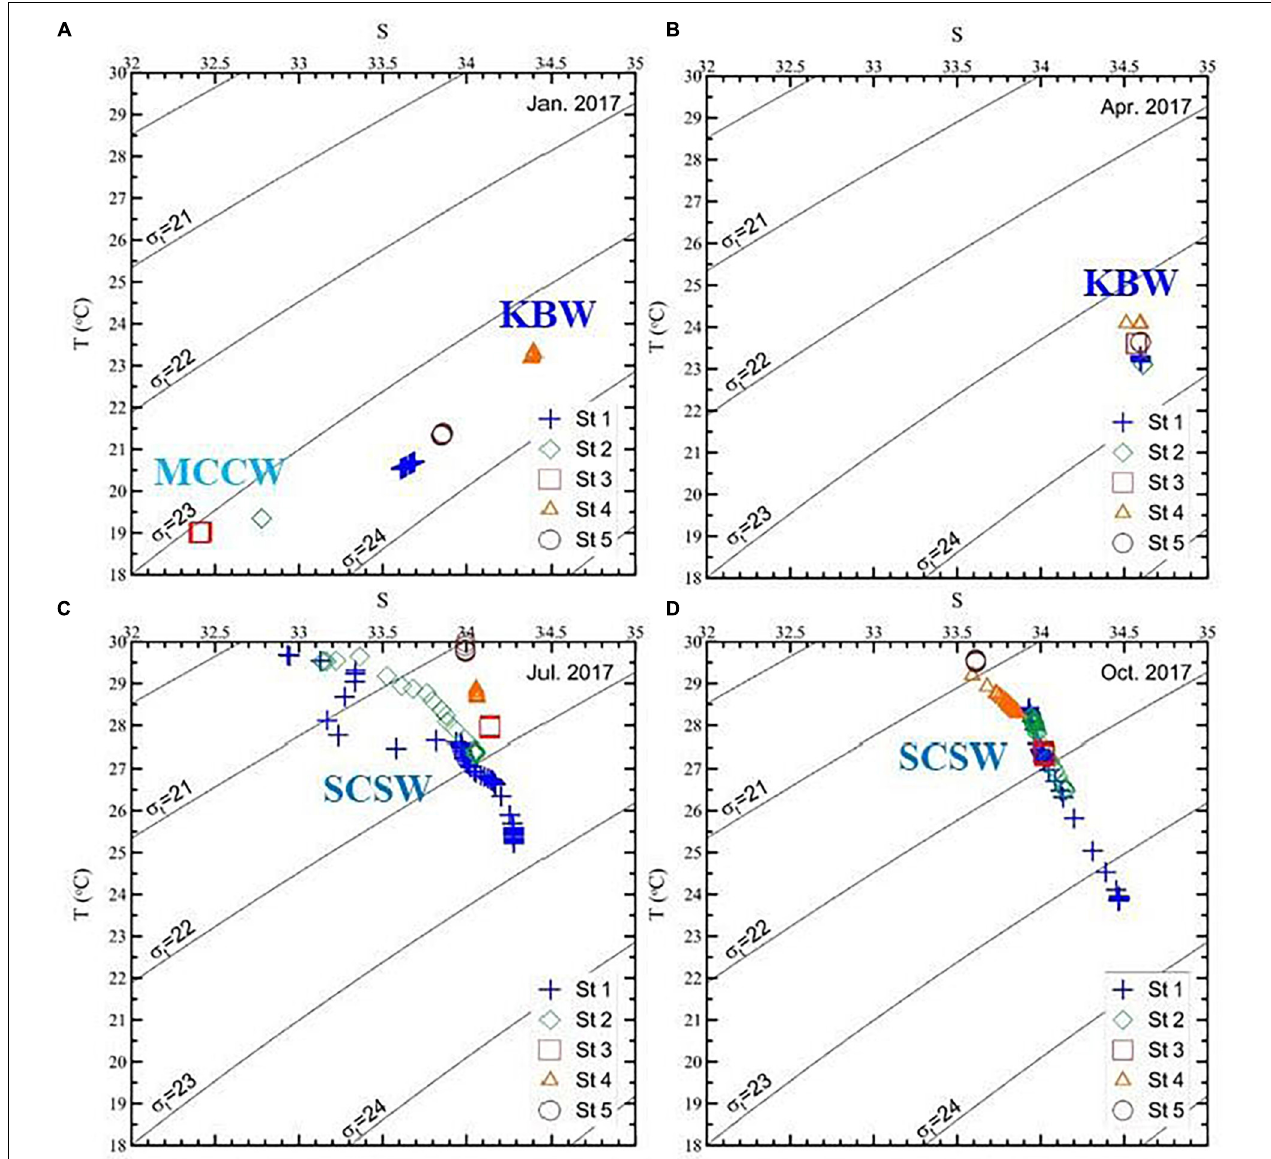
FIGURE 4 | Temperature (T) versus salinity (S) for (A) winter, (B) spring, (C) summer, and (D) autumn in the Taiwan Strait in 2017. The primary water masses in the Taiwan Strait were the Mixed China Coastal Water (MCCW) and the Kuroshio Branch Water (KBW) in winter, the Kuroshio Branch Water (KBW) in spring and the South China Sea Water (SCSW) in summer and